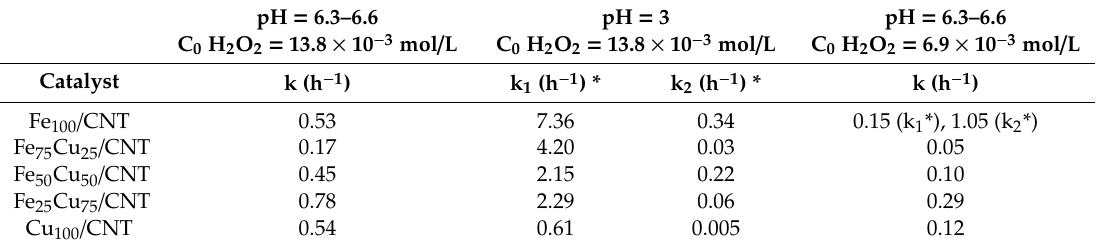
Figure 6. Plots of ln (C t / C 0 ) versus time for the paracetamol (C 0 = 50 mg / L) at 25 ◦ C on Fe 100 − x Cu x / CNT samples. C 0 of H 2 O 2 : 13.8 × 10 − 3 mol / L. Table 4. Values of apparent constants for pseudo-first-order kinetics of paracetamol decomposition. C 0 of paracetamol: 50 mg / L.